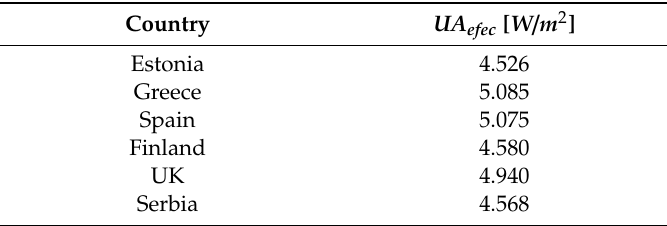
Table 2. Averaged UA efec values for each